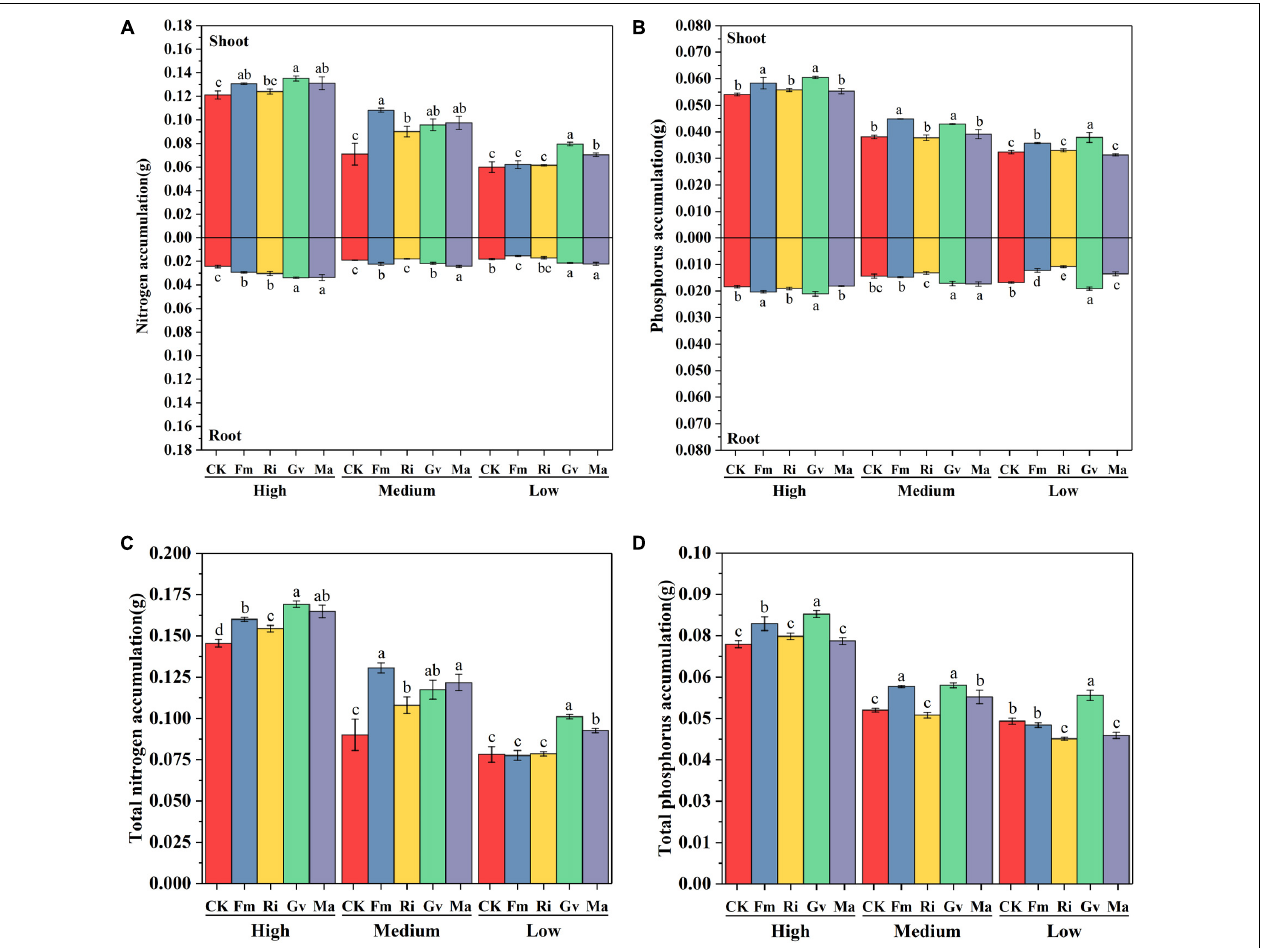
FIGURE 6 | Effects of AMF inoculation on nitrogen accumulation (A) , phosphorus accumulation (B) , total nitrogen accumulation (C) , and total phosphorus accumulation (D) of aboveground and belowground cherry tomato under different nutrient